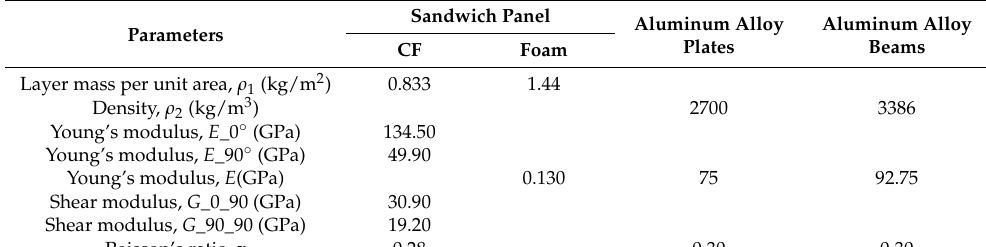
Table A1. Major material parameters used for the framework.